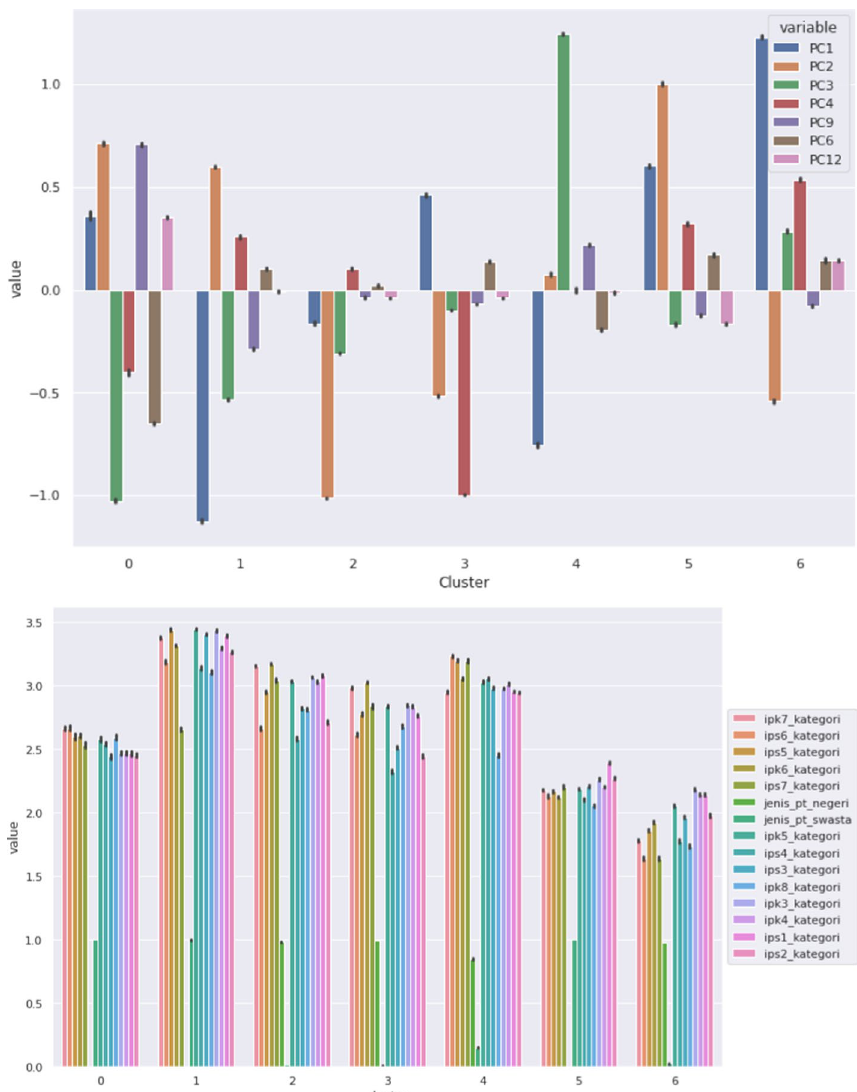
Fig. 10 Bar plot analysis by cluster using a seven highest-variance PCs, b 15 highest-variance original features